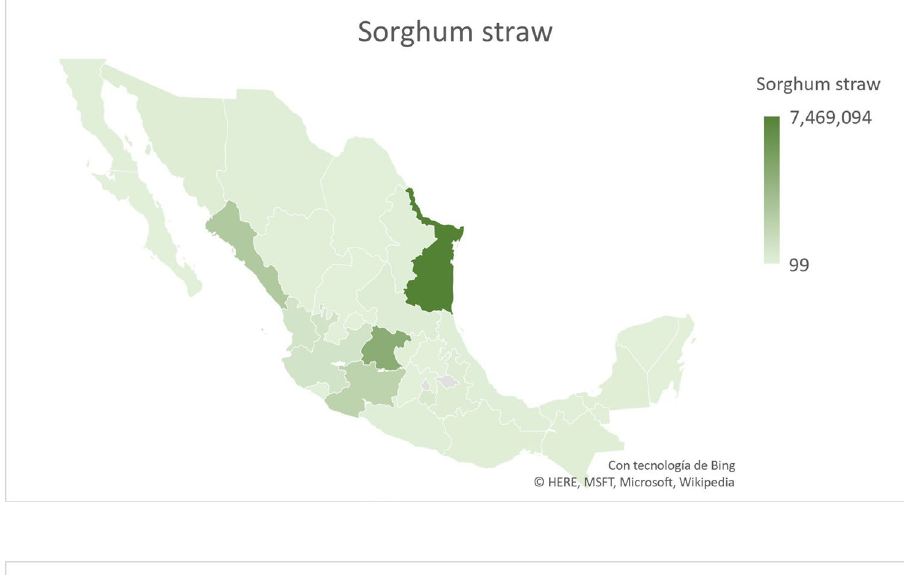
Fig. 5 Wheat straw availability (Mg/year)